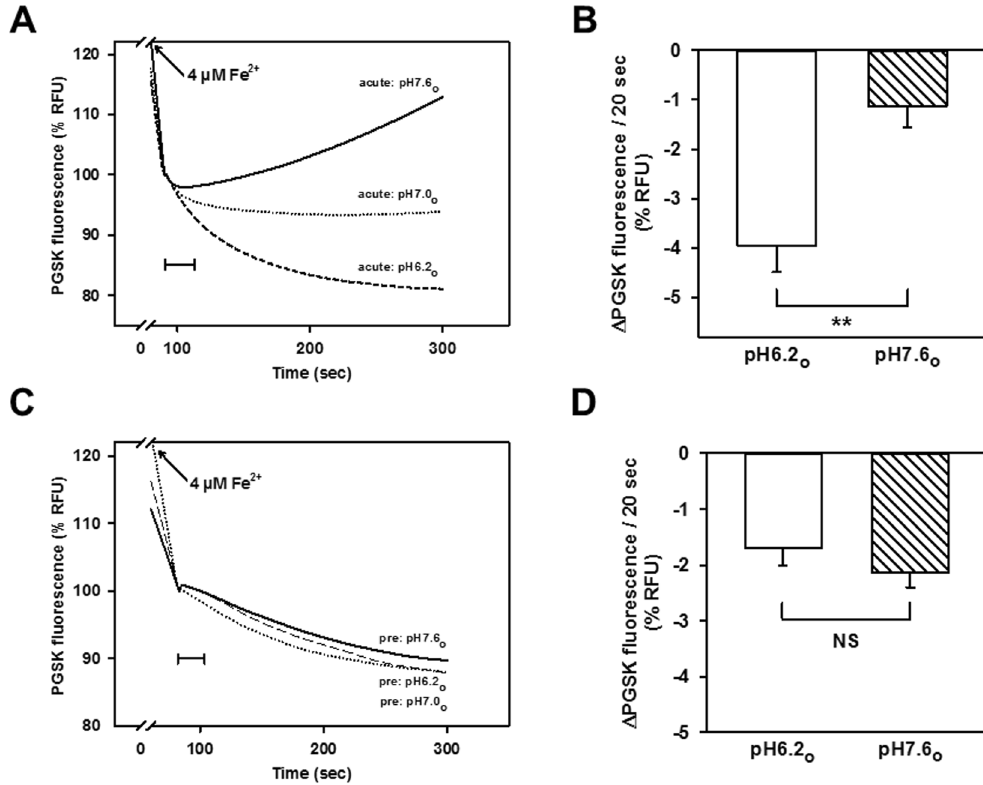
Figure 2. Fe 2 + uptake in mitochondria overexpressing rDMT1 is increased by an inward-directed proton gradient. PGSK-loaded mitochondria (pH 7.0 i ) from doxycycline-induced rDMT1-HEK293 cells were suspended in pH 6.2 o , 7.0 o , or 7.6 o assay buffer immediately ( A , B ) or pre-equilibrated for 10 min in the assay buffer ( C , D ) prior to quenching induced by 4 µ M Fe 2 + . ( A , C ) Representative traces of the fluorescence time course are shown. ( B , D ) Statistical analyses of second phase PGSK quenching. Initial slopes of quenching, as indicated by the 20s-scale bars in ( A and C ), are plotted as means ± SEM (8–9 measurements in 4 independent experiments) for pH6.2 and pH7.6, respectively. Fluorescence quenching ( −Δ PGSK), reflecting Fe 2 + uptake, was normalized to the respective initial value of the second phase that was set to 100%. ** P < 0.01; NS, not significant. RFU, relative fluorescence